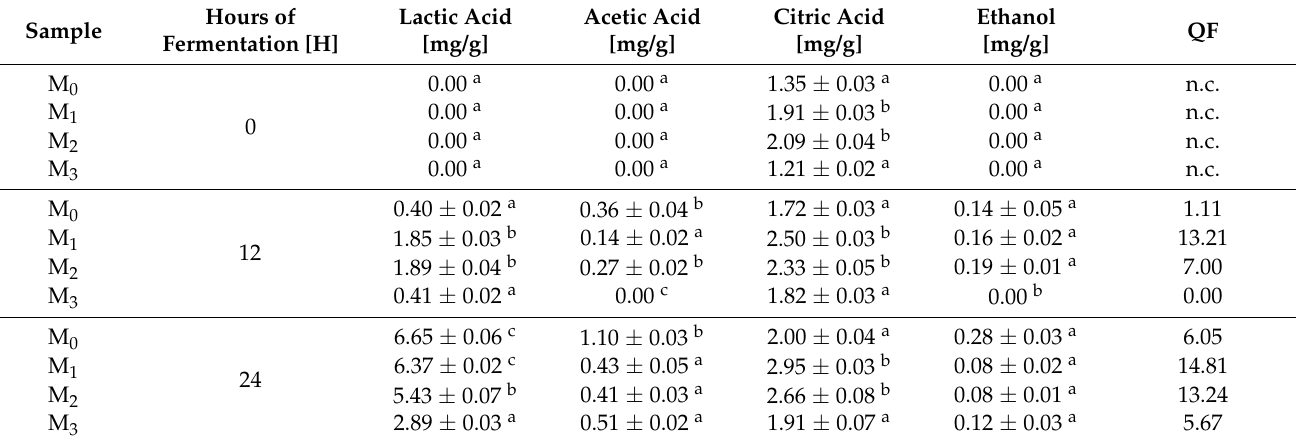
Table 3. Organic acids and ethanol content in sourdoughs with wheat flour (M 0 ), einkorn flour (M 1 ), spelt flour (M 2 ), and emmer flour (M 3 ), fermented for 0, 12, and 24 h with Lactiplantibacillus plantarum ATCC